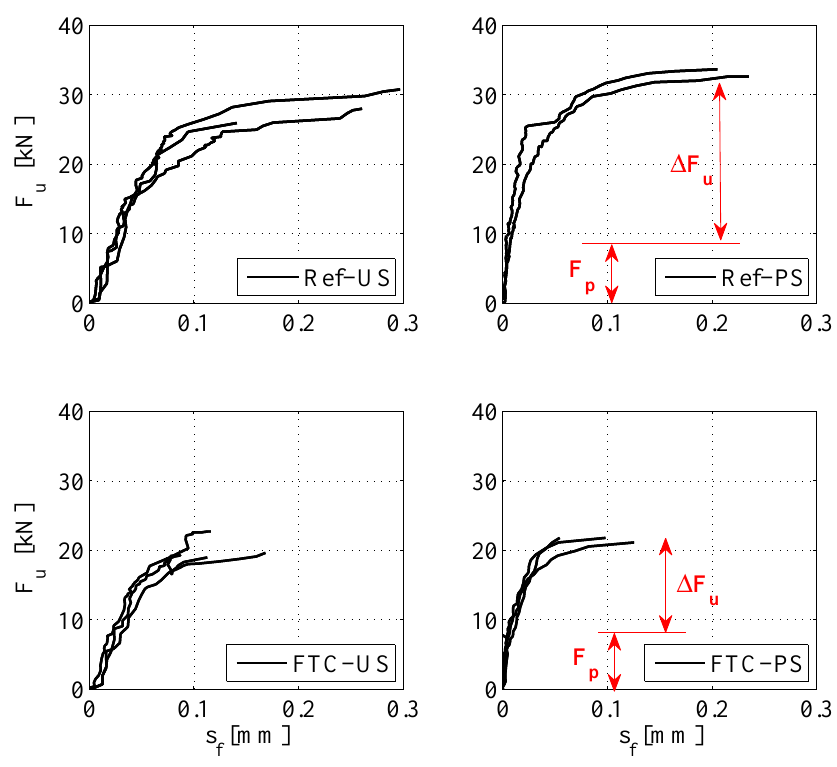
Figure 10. Force-slip relationship of all